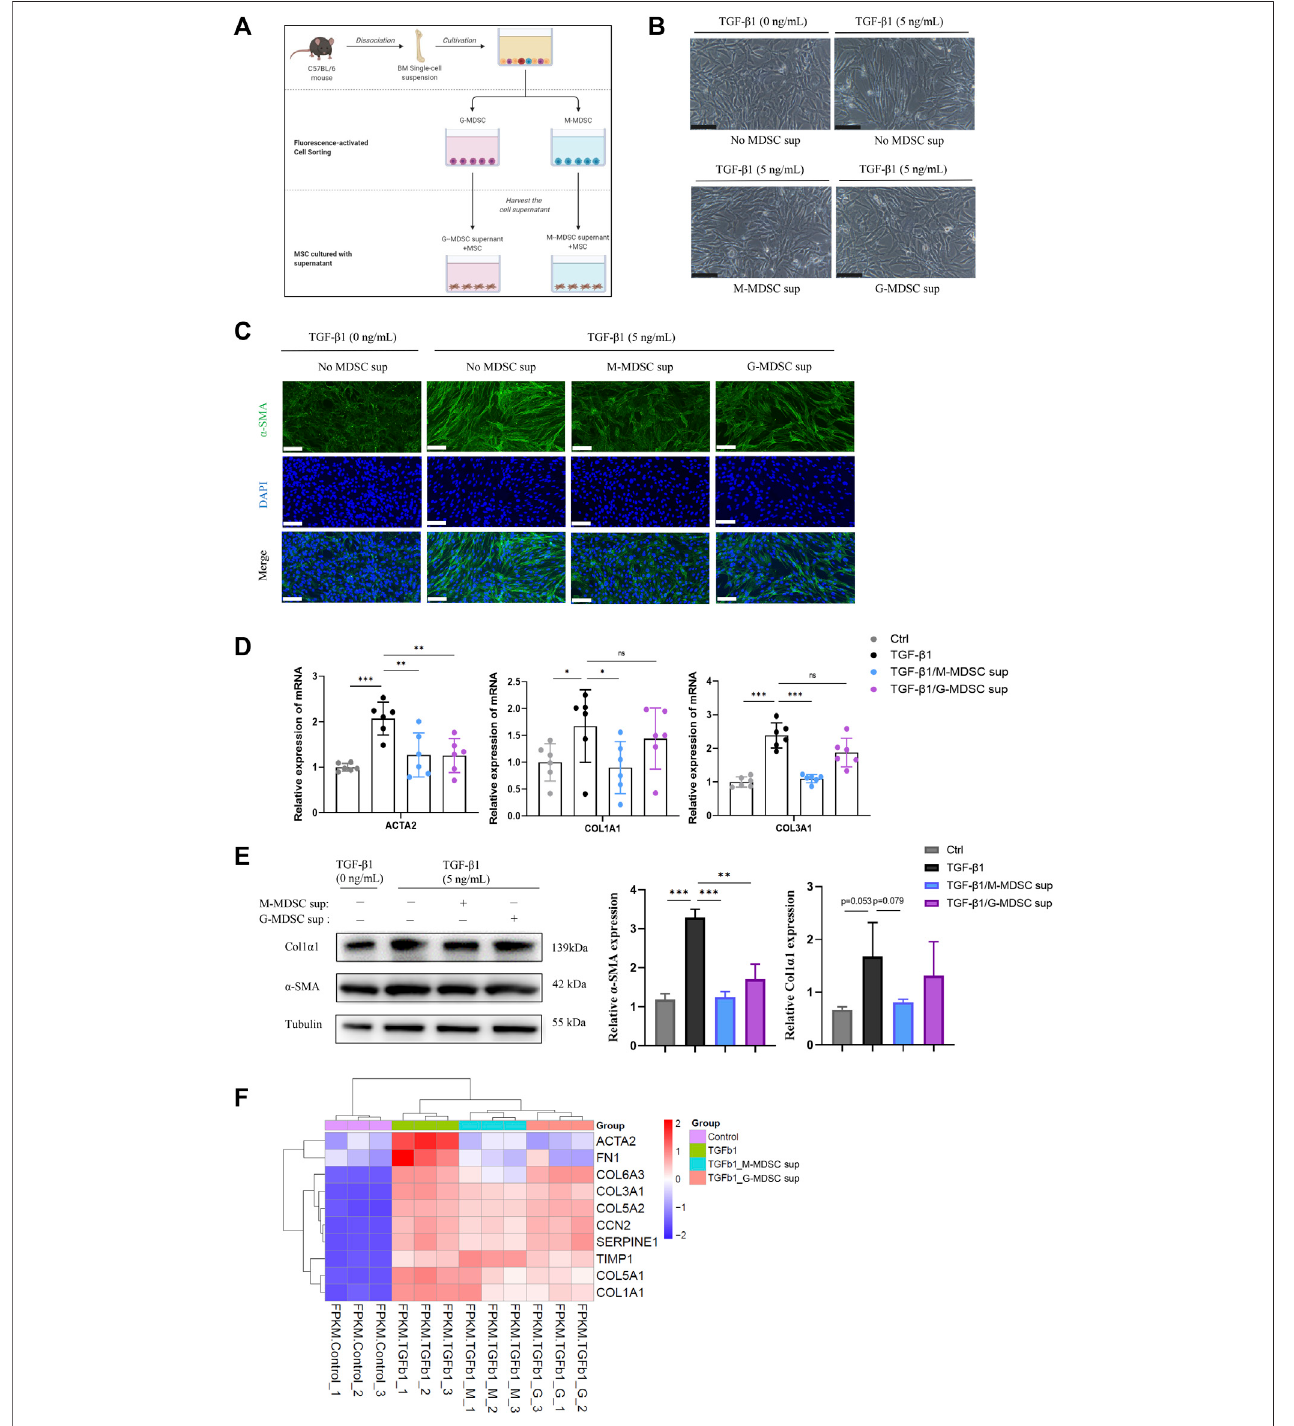
FIGURE 2 | M-MDSC supernatant inhibits the TGF- β 1-induced myo fi broblastic differentiation of MSCs. (A) Bone marrow CD11b + Ly6G − Ly6C high M-MDSCs and CD11b + Ly6G + Ly6C low G-MDSCs were sorted by fl ow cytometry, and the culture supernatants were collected after another 24 h of culture in normal medium. The myo fi broblastic differentiation of MSCs was evaluated in the presence of G-MDSC supernatant or M-MDSC supernatant containing TGF- β 1 (5 ng/mL) for 24 h. (B) MorphologyofMSCstreatedwithTGF- β 1,TGF- β 1/M-MDSC supernatant orTGF- β 1/G-MDSCsupernatant.Scalebar:100 μ m. (C) Immuno fl uorescencestaining of α -SMAinMSCs.Scalebar:100 μ m. (D) mRNAexpression ofACTA2,COL1A1andCOL3A1inMSCswasnormalizedtoGAPDHexpressionand analyzed byqPCR. Values were expressed asmean ± standard deviation (mean ± SD). (E) Representative western blot and average data for α -SMAand col1 α 1in mesenchymal stem cells ofeach experimental group, normalized toexpression oftubulin.Valueswereexpressed asmean ± standarddeviation(mean ± SD). (F) AheatmapofACTA2,COL1A1, COL3A1, COL5A1, COL5A2, COL6A3, FN1, SERPINE1, CCN2 and TIMP1 expression in each sample. * p < 0.05; ** p < 0.01; *** p < 0.001.